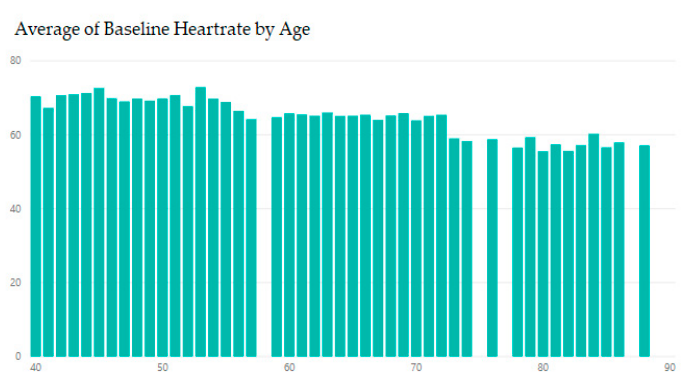
Figure 3. Heart rates by age .